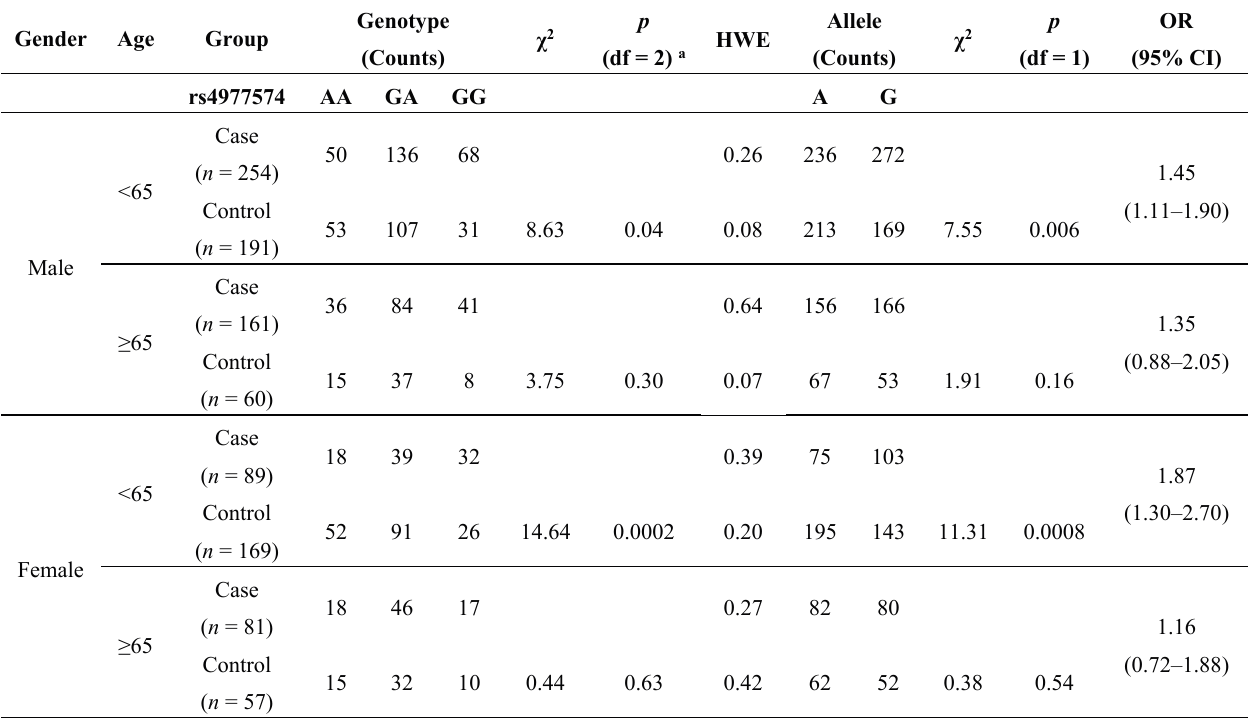
Table 4. Association test in different age subgroups.